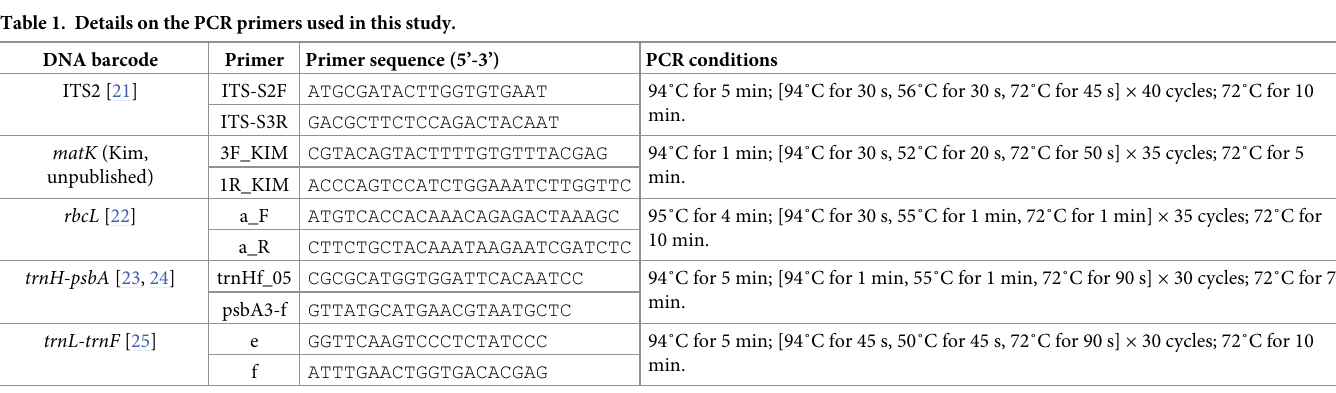
Table 1. Details on the PCR primers used in this study. DNA